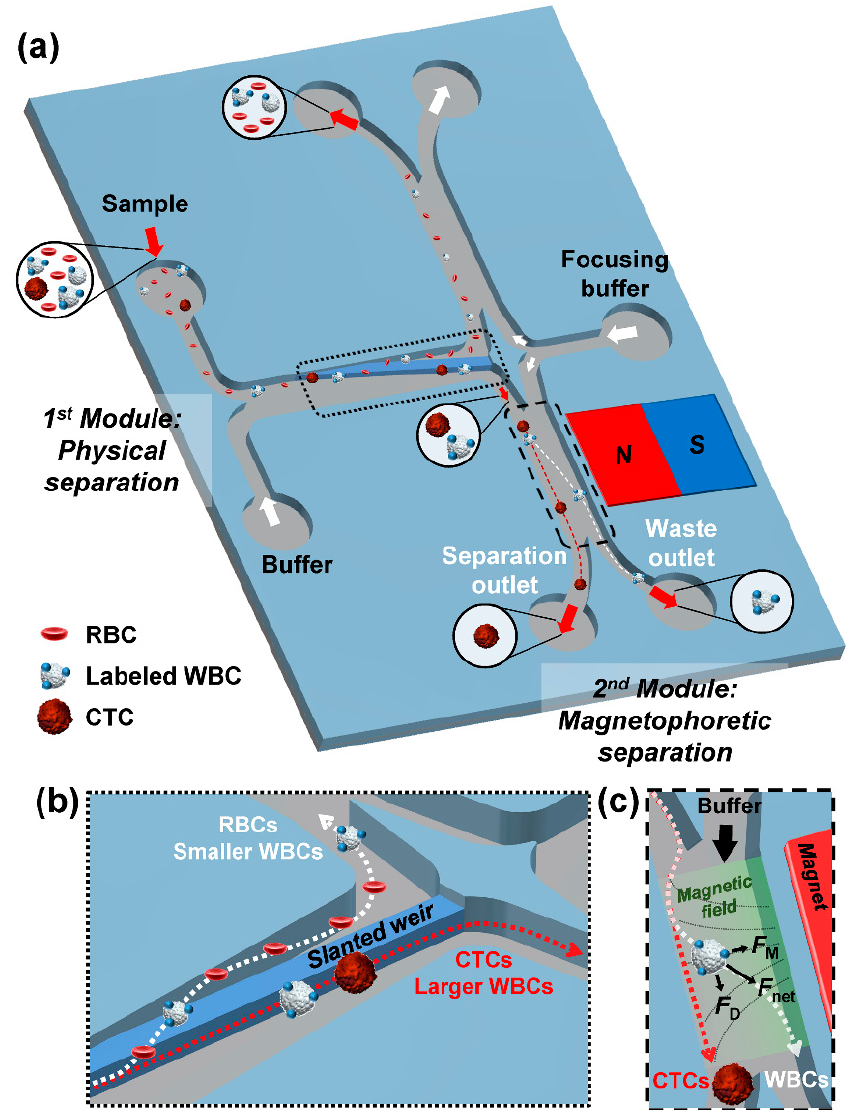
Figure 1. Schematic illustrations of the microfluidic separation device. ( a ) Overview of the enrichment sequence. Enlarged illustrations show ( b ) the physical separation in the first module, and ( c ) the magnetophoretic separation in the second module. Dotted arrows represent trajectories of cells.